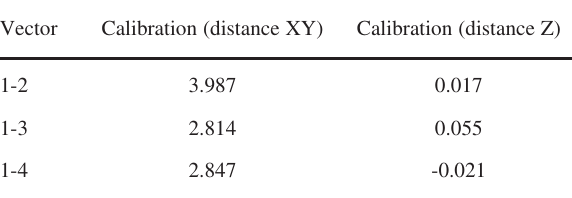
Table 1. Calibration results (distance in metres) of the GPS 3DF system perfomed while BIO Hespérides was in Cartagena harbour.